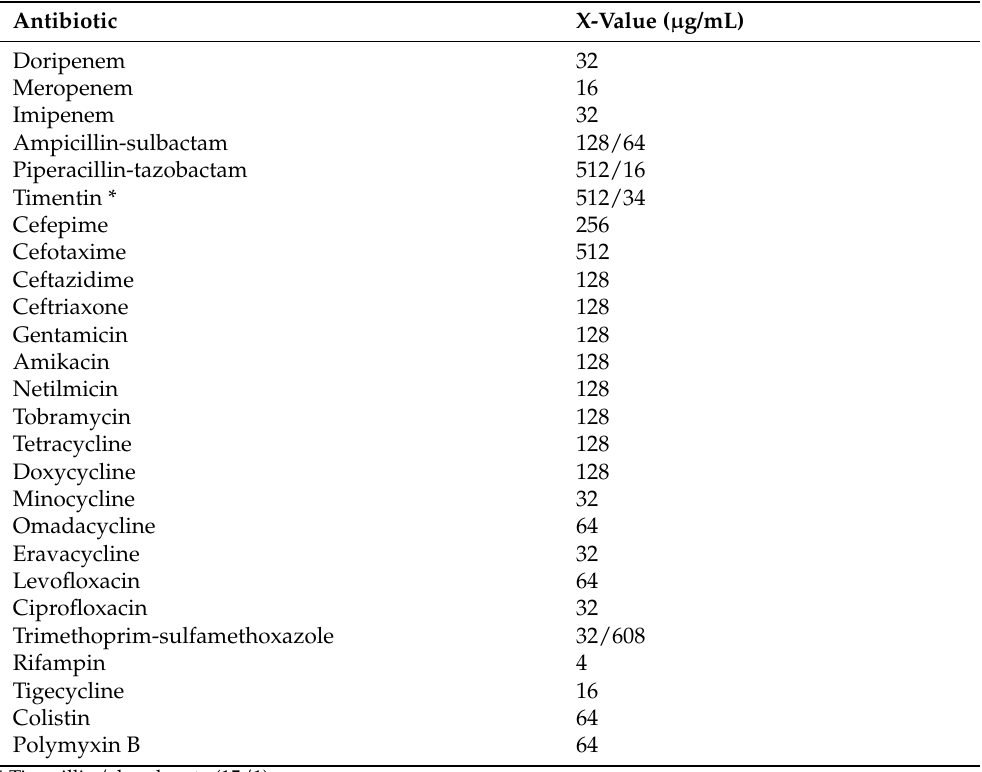
Table 4. Starting “X” concentration of drugs for the MIC